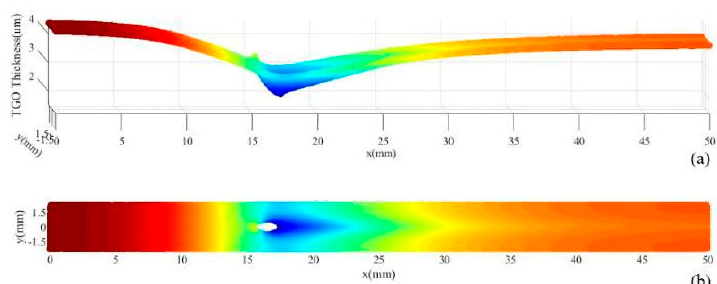
Figure 9. Profile of the top surface of the TGO layer after 500 h oxidation under operating conditions: ( a ) the main view and ( b ) the top view. Reprinted with permission from [77]; Copyright 2019 Elsevier.